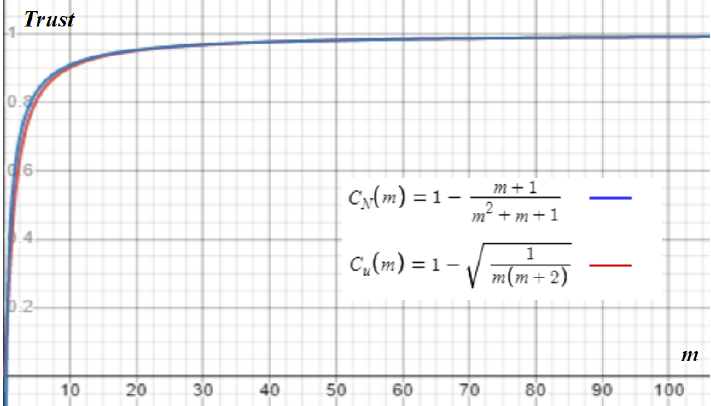
Figure 6. Formula of